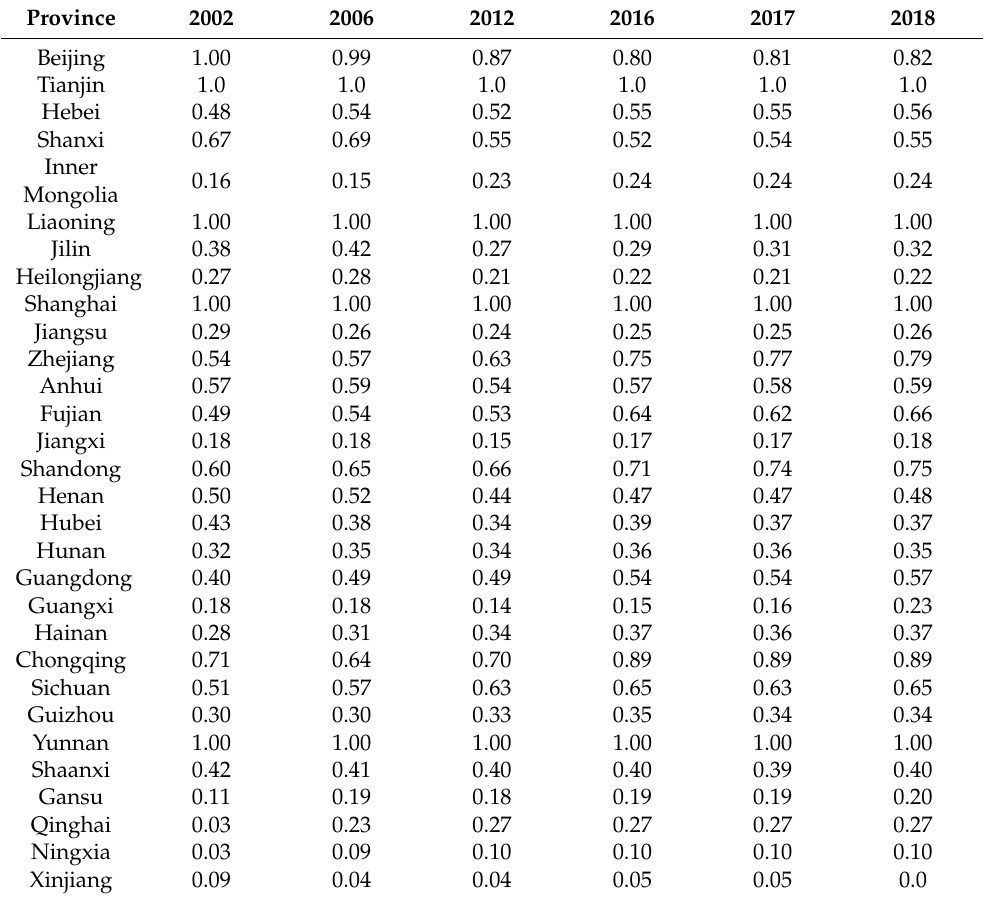
Table A1. Total-factor water efficiency of